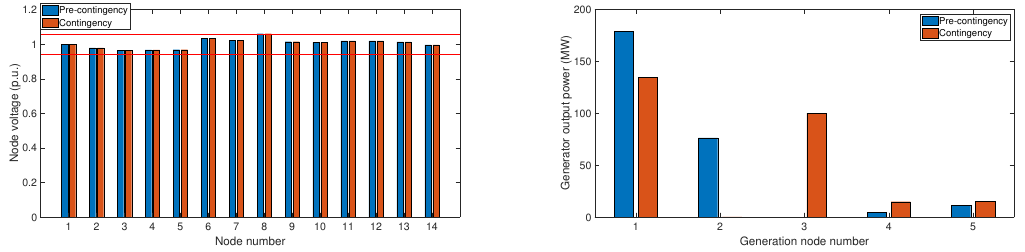
Figure 12. Voltage and power dispatched in the extended power system prior to and after contingency of branch 5 (generation nodes are, respectively, nodes 1, 2, 3, 6, and